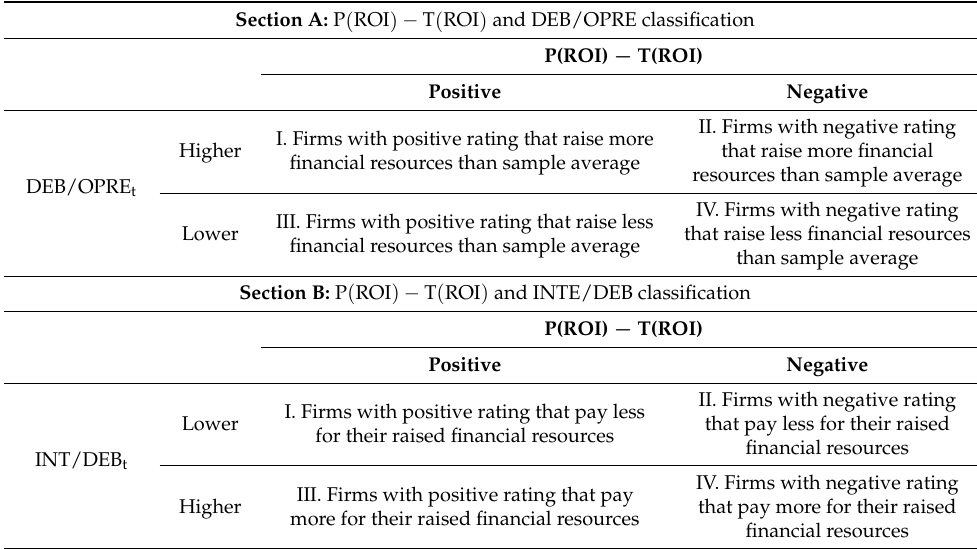
Table 1. Cross-section matches between IRM results and actual bank allowance